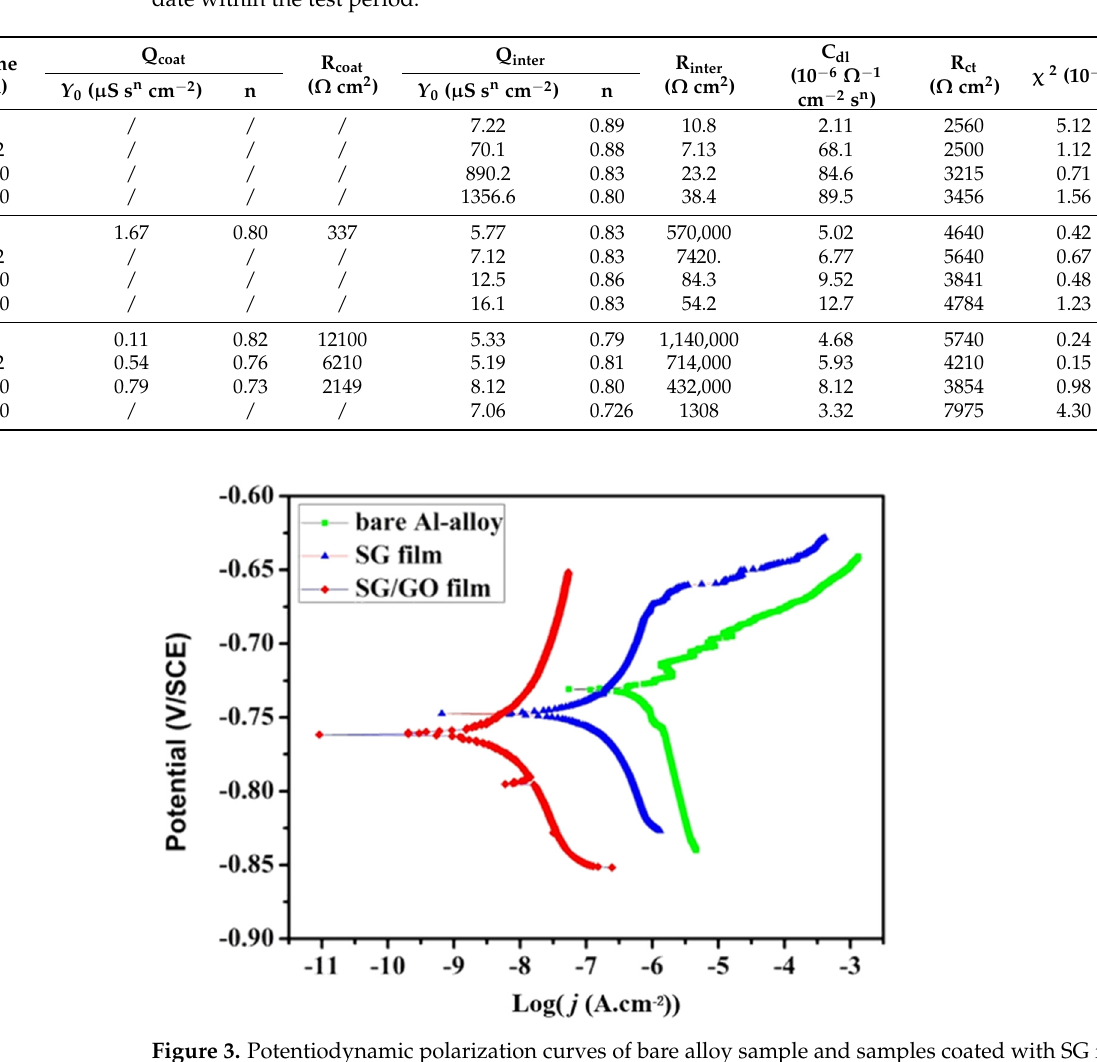
Table 3. Resistances (R coat , R int , R ct ) and capacitance (Q coat , Q int, C dl ) parameters extracted from EIS date within the test period.